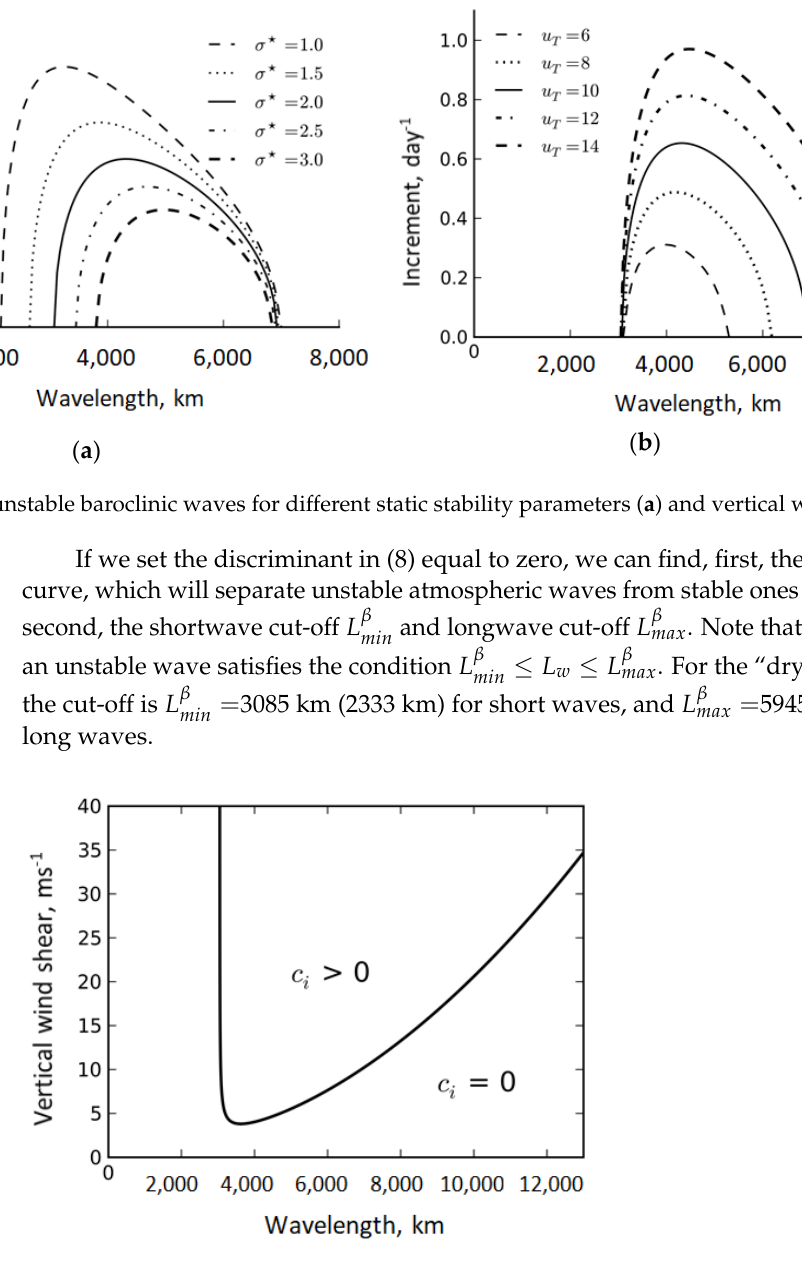
Figure 1. Increments of unstable baroclinic waves for “dry” and “moist” 𝛽 − plane models.